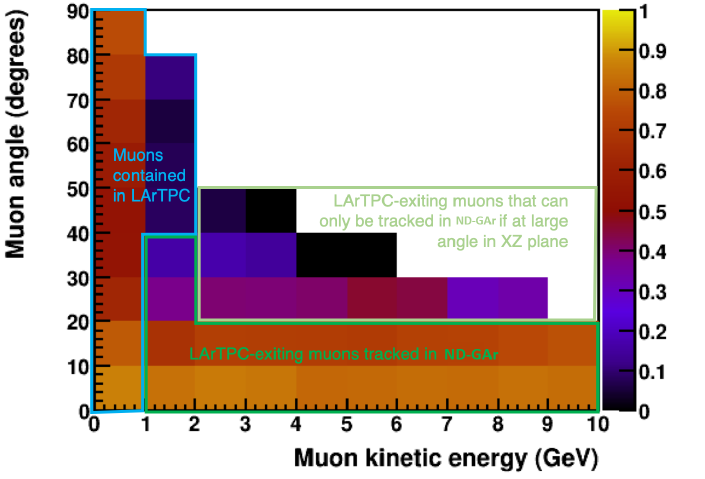
Figure 56. Acceptance of the reference ND-GAr design (500cm diameter, 500cm in length) for muons created in neutrino interactions in the upstream